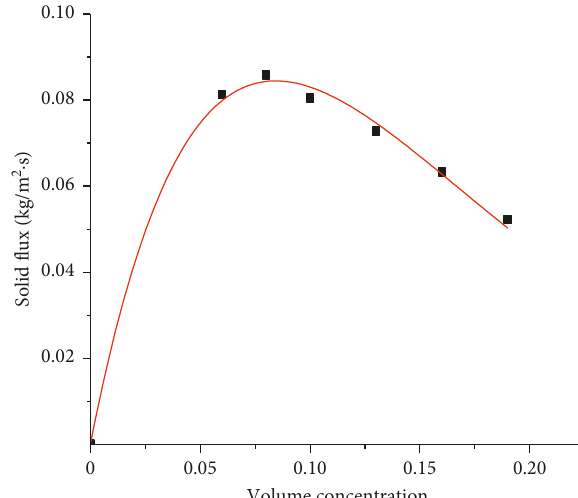
Figure 4: Fitting formula curve of solid flux